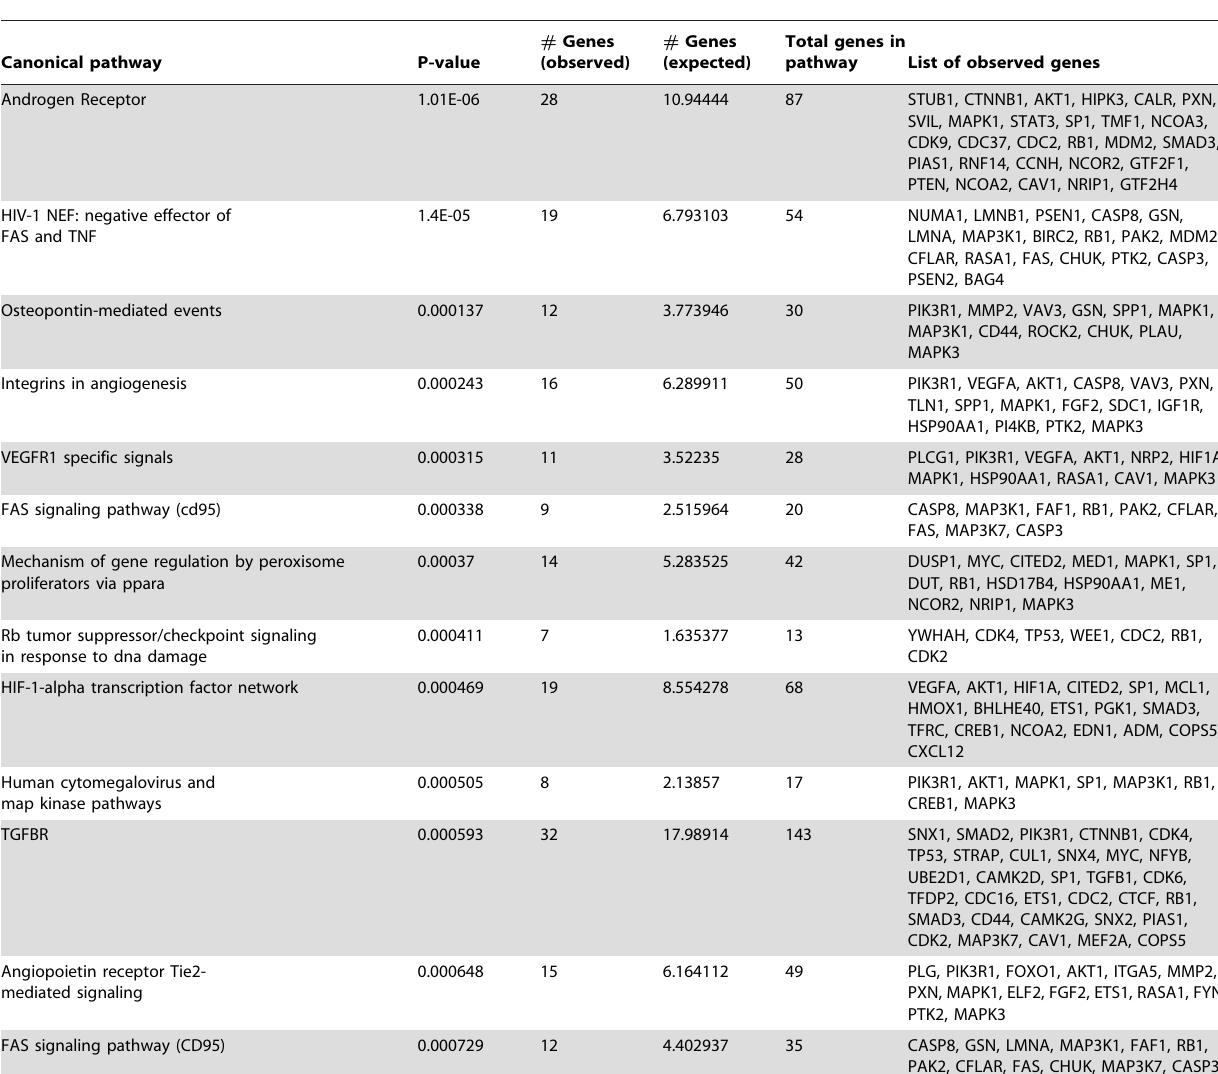
Table 2. Canonical signal transduction pathways represented by the 1388 differentially expressed transcripts from ESC generated from either in vivo derived or in vitro cultured